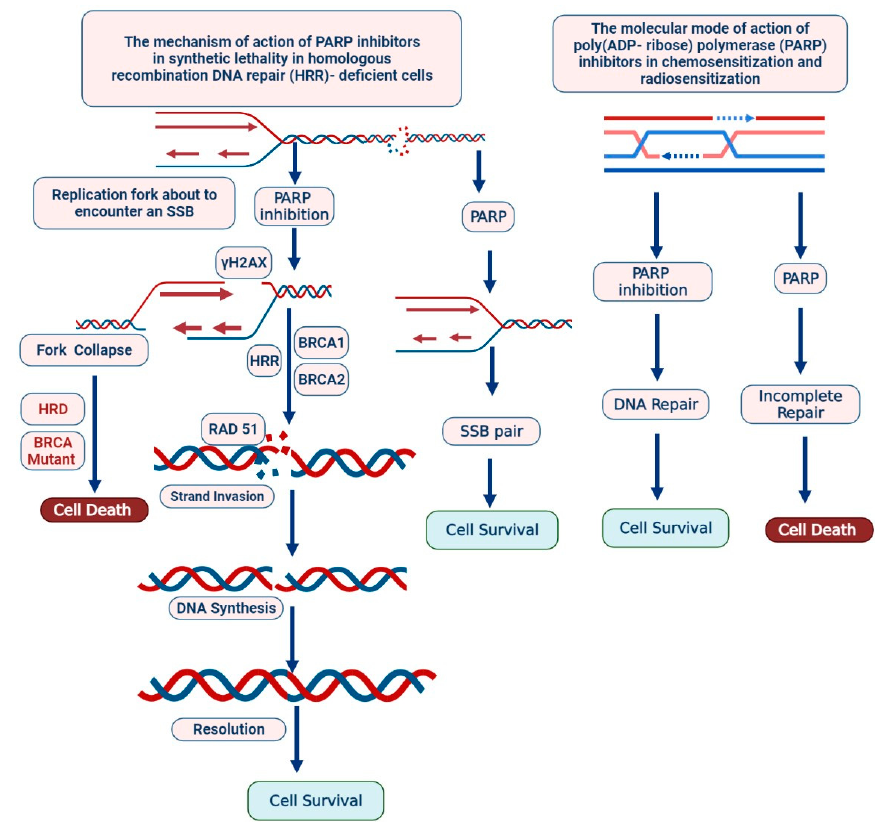
Figure 5. The mechanism of PARP inhibitors is synthetic lethality in homologous recombination DNA repair (HRR) deficient cells. The molecular mode of action of poly (ADP ribose) polymerase inhibitors in chemosensitization and radiosensitization.